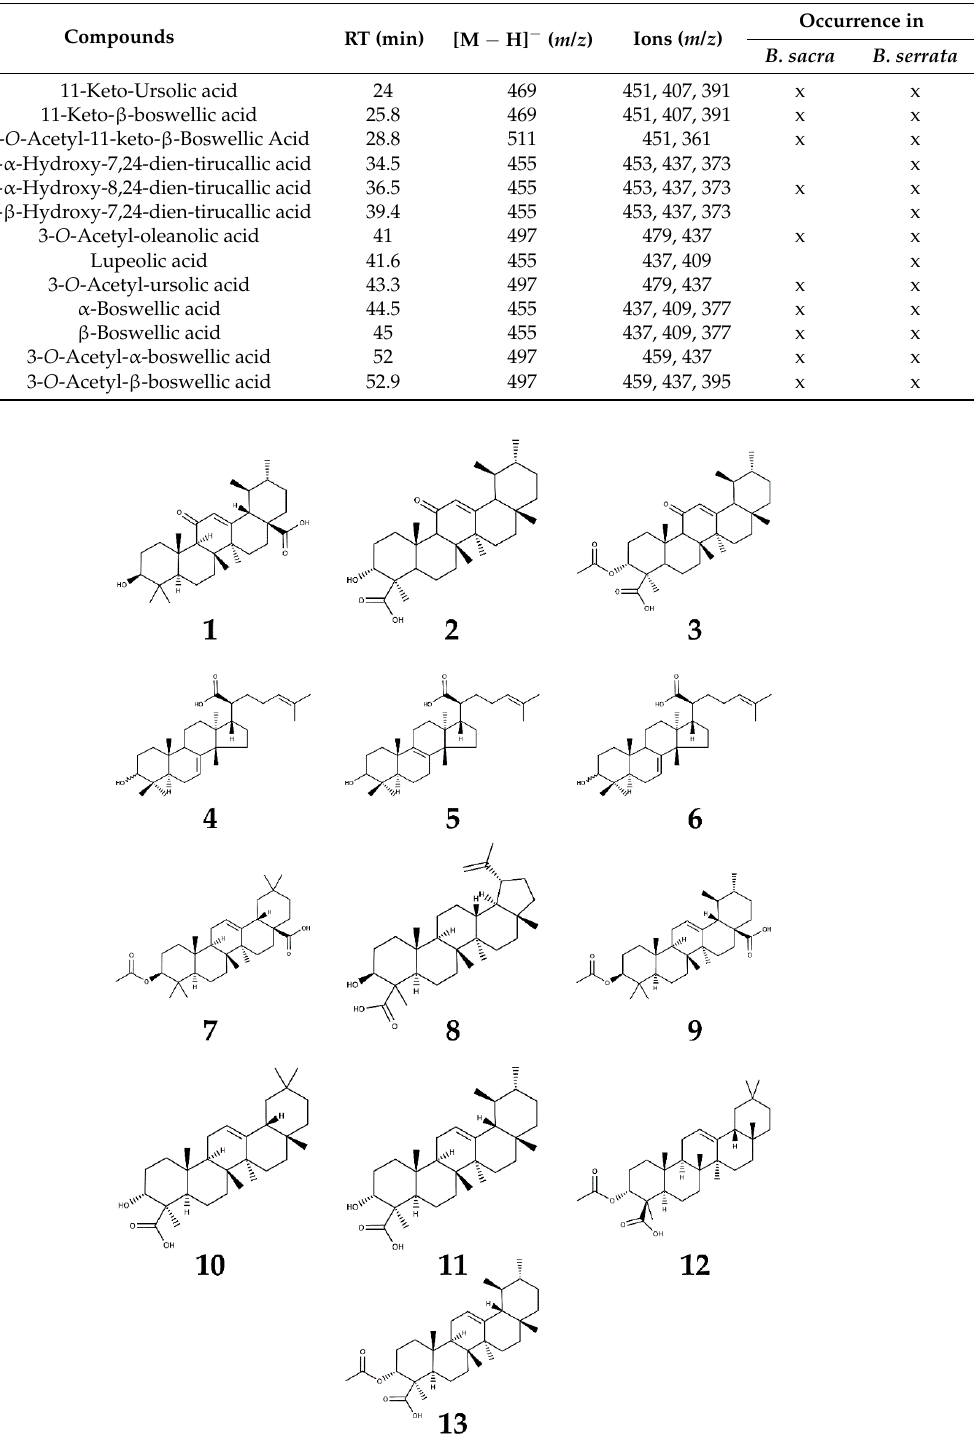
Figure 1. Chemical structure of the boswellic acids identified in Boswellia serrata and Boswellia sacra . Numbers correspond to compounds listed in Table 1.